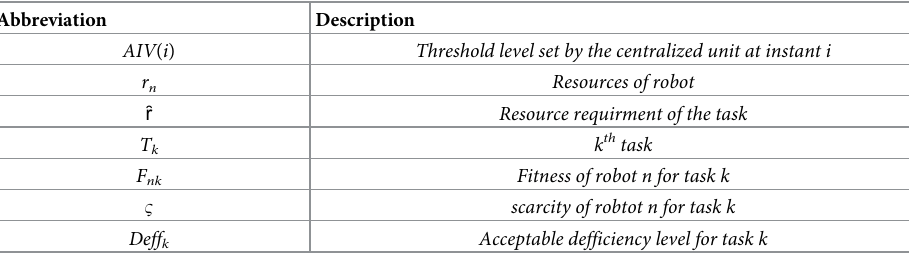
Table 1. List of abbreviations used in the methodology.